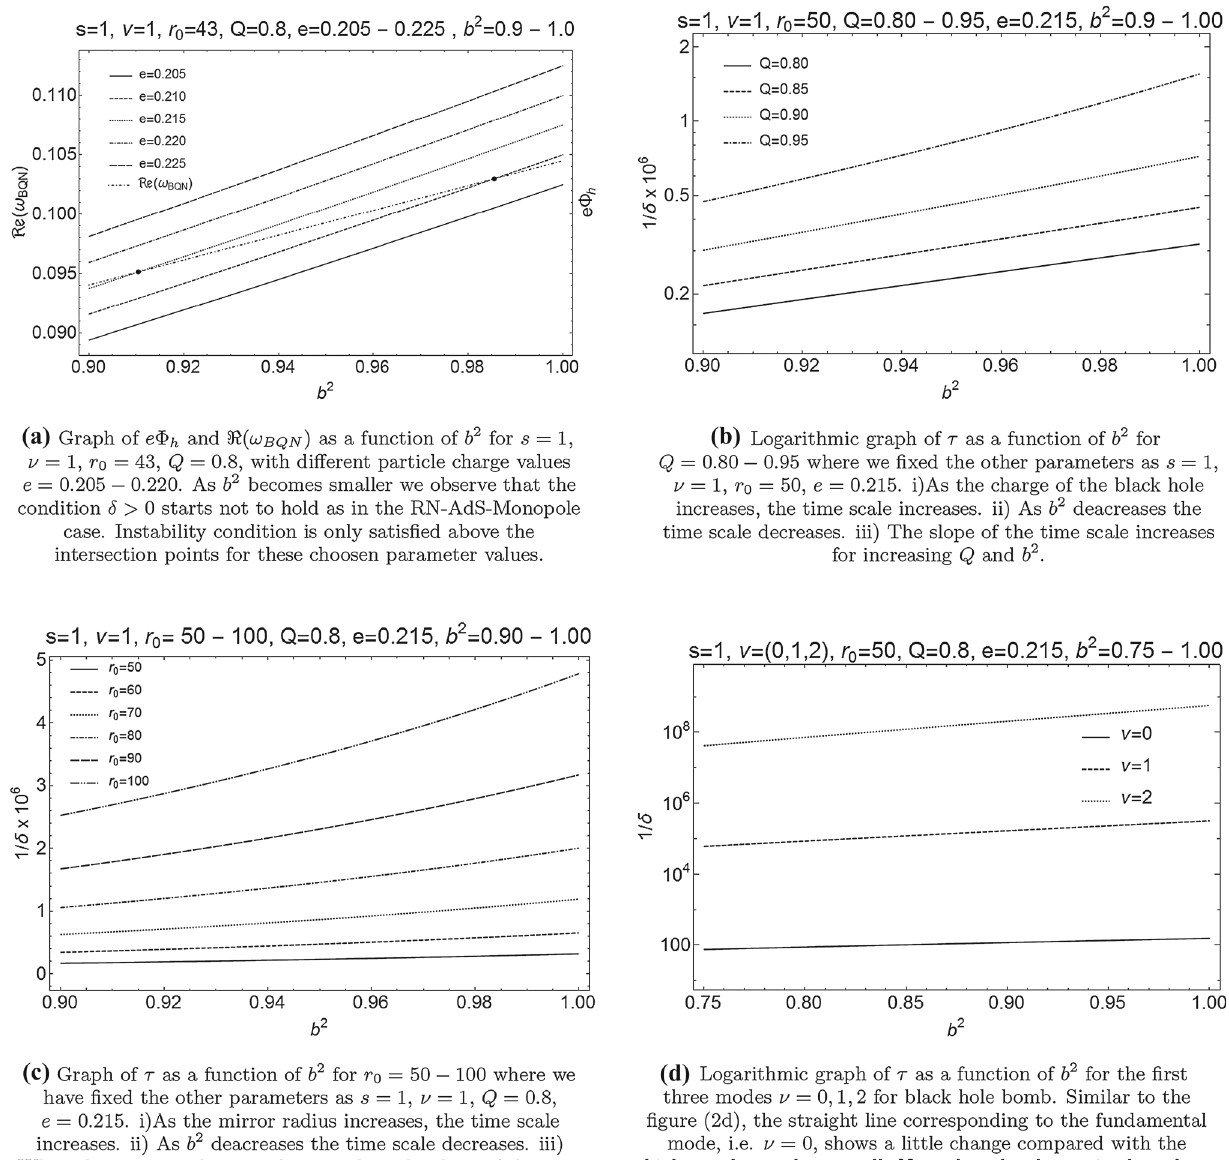
Fig. 3 a Specifies the regime of the superradiant scattering and the variation of the threshold frequency with the gravitational monopole term b 2 = 1 − 8 πη 2 . As we have discussed in the text, the threshold frequency increases with increasing η . b – d corresponds to the differ-